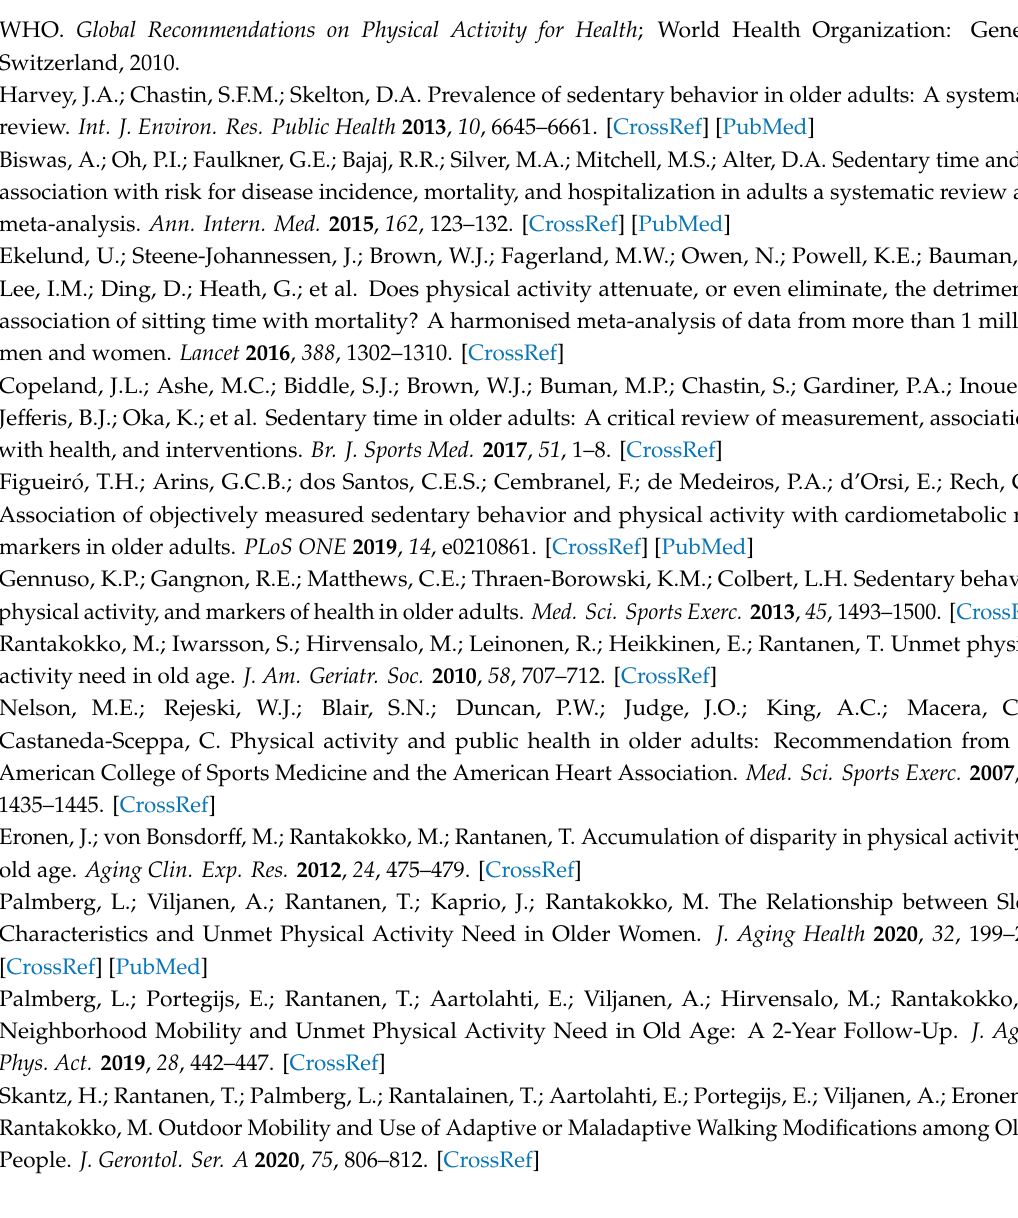
Figure S1: Accelerometer-assessed mean amplitude deviation (MAD) of 24 h of activities during weekdays and weekends. The average values are calculated from all